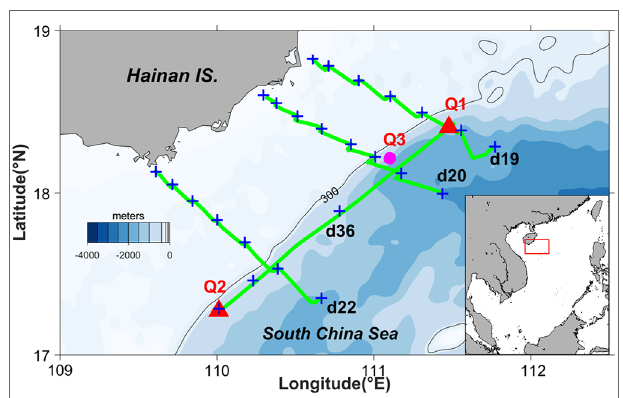
FIGURE 2 | Topography of the northwestern SCS with the locations of the CTD stations (blue crosses), along-track ADCP transects (green curves), mooring stations (red triangles), and the day-time anchored station (purple solid circle). The inset at the lower right is a location map of the SCS with simplified bathymetry, and the red box is the focus region of this study.